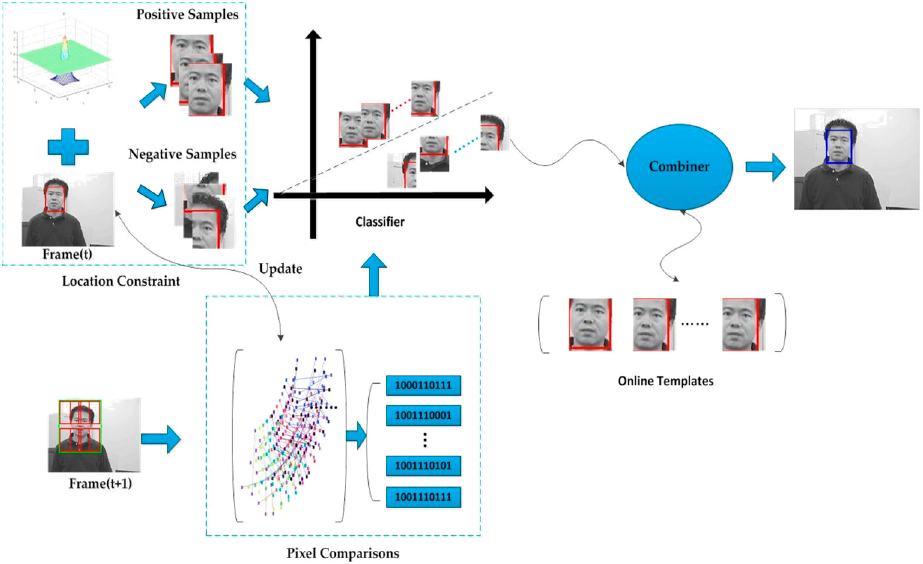
Figure 1. Flow chart of the AFCL framework.